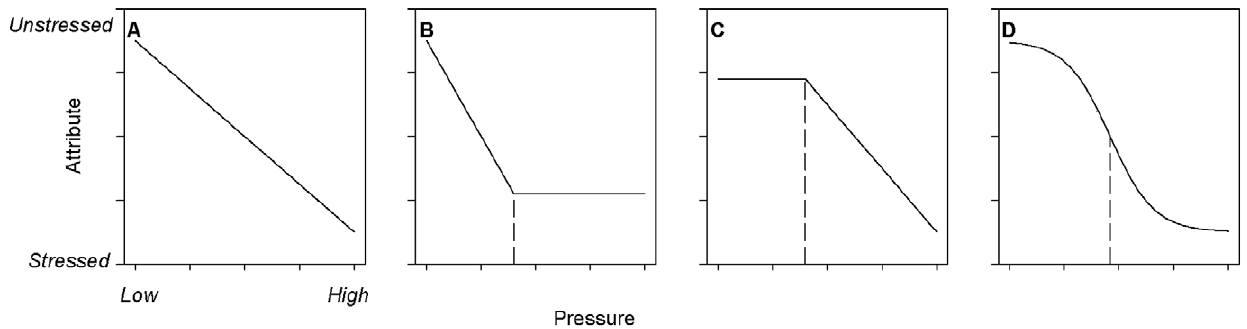
Figure 1. Relationships between hypothetical ecosystem attributes and anthropogenic pressures. Attribute values range from unstressed to stressed (sensu [13]), and the levels of the pressures applied have been scaled relative to a theoretical maximum. A utility threshold cannot be defined objectively for the linear model (a), but can be defined objectively for the two piecewise models (b and c) and the sigmoidal model (d). Equations for the models and the location of the utility thresholds are described in Text S1. In (b-d), the threshold pressure is indicated by the dashed lines.